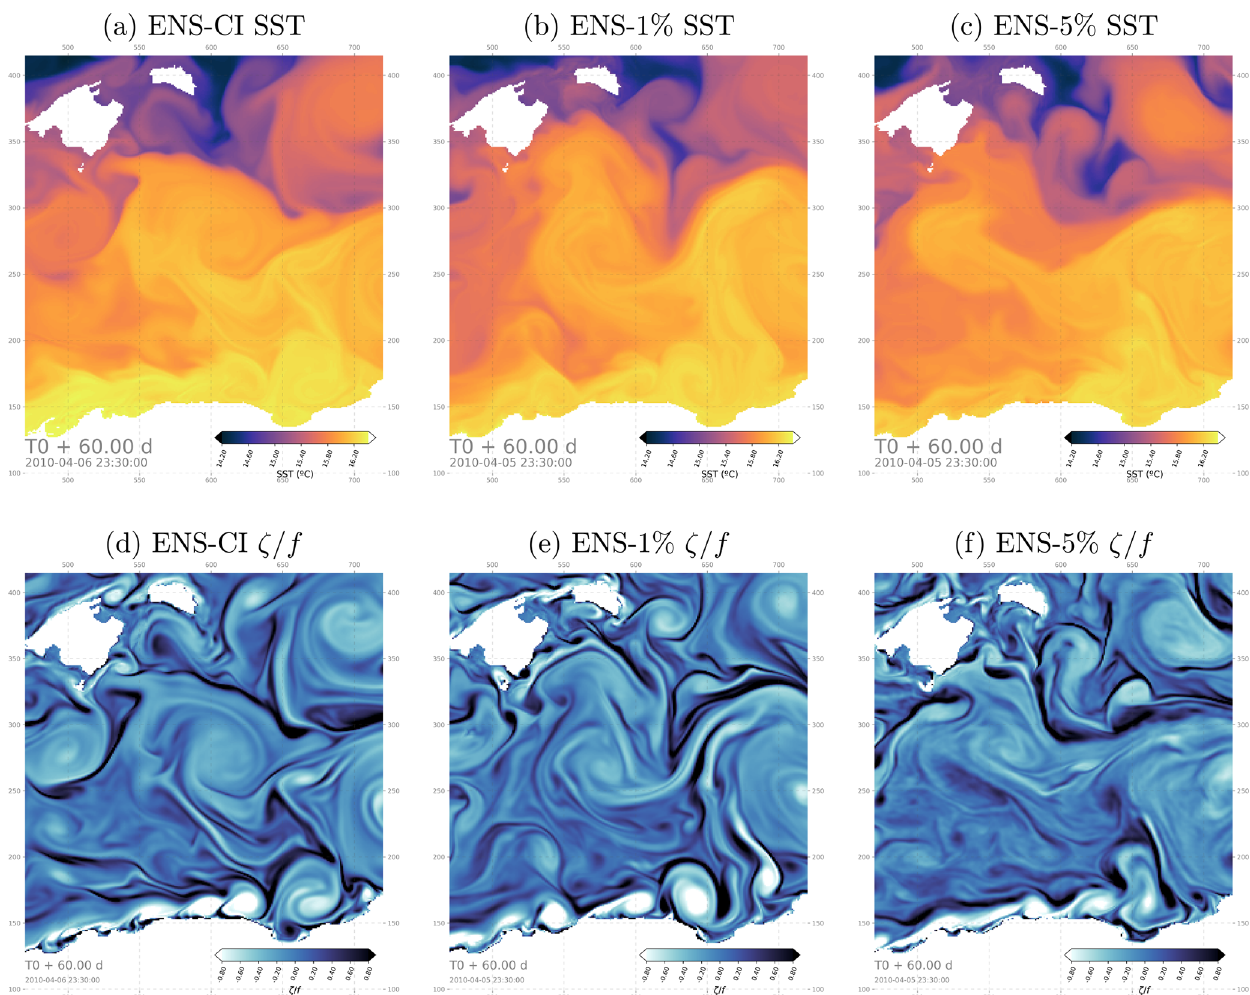
Figure 3. Hourly snapshots of sea surface temperature (a–c) and relative vorticity (d–f) from one example member after 60d in the ensemble experiments ENS-CI, ENS-1% and ENS-5% focusing on a 250 × 250 grid point subregion southeast of the Balearic Islands (box b in Fig.